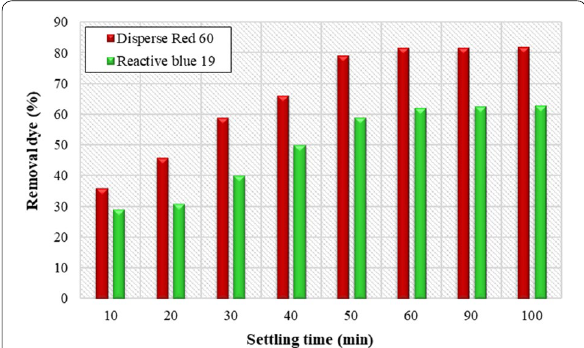
Fig. 7 Effect of settling time on removal efficiency of Disperse red 60 and Reactive blue 19 dyes. (Initial pH 11, Alcea rosea = concentration 200 mg/L and initial dye concentration 40 mg/L = = for Disperse experiments; initial pH 11, concentration 250 mg/L = = and initial dye concentration 20 mg/L for Reactive experiments; = rapid-mixing speed 180 rpm; rapid-mixing time 3 min; = = slow-mixing speed 10 rpm; slow-mixing time 15 min) = =